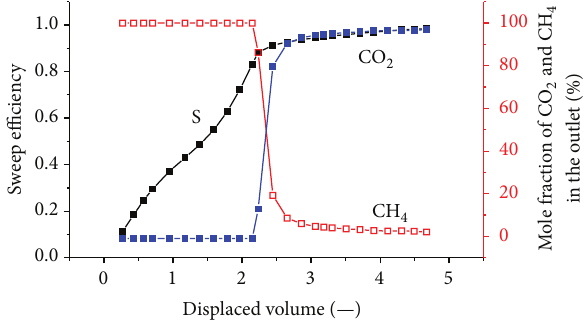
Figure 10: The sweep efficiency and concentrations of produced gas against displaced volume at 1.8 MPa.